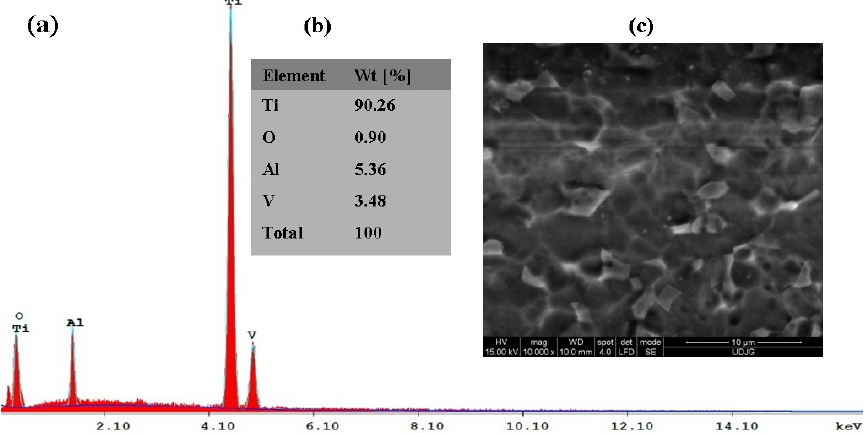
Figure 3. SEM surface micrographs and EDX analysis of the untreated Ti6Al4V grade 5 alloy im- plant: ( a ) EDX spectrum; ( b ) EDX elemental analysis; and ( c ) SEM surface morphology. ( a ) EDX spectrum; ( b ) EDX elemental analysis; and ( c ) SEM surface